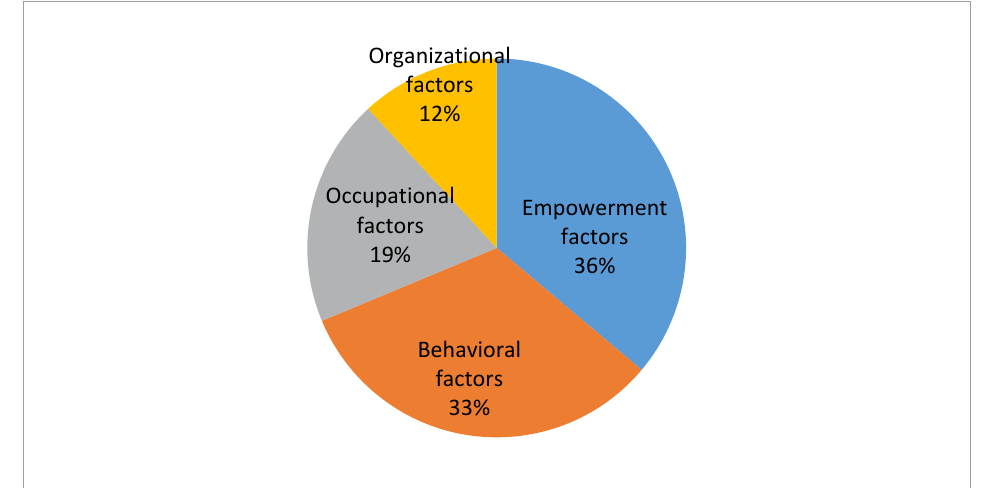
Fig. 6. The relative priority diagram of HRD dimensions for SOE